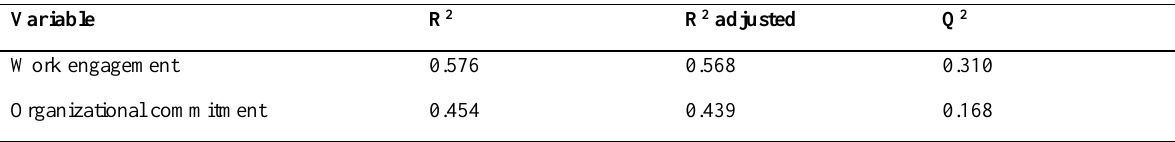
Table 3: Structural Model Testing